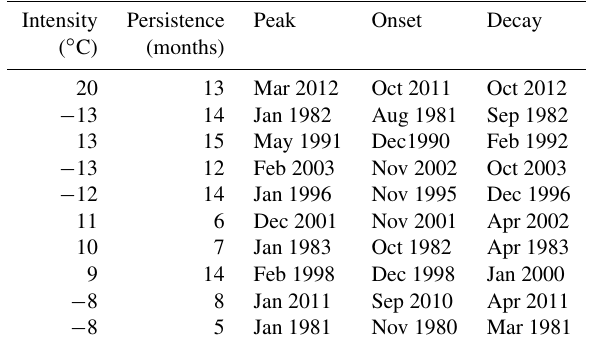
Table 1. A total of 10 LIS detrended temperature events ranked by the magnitude of their